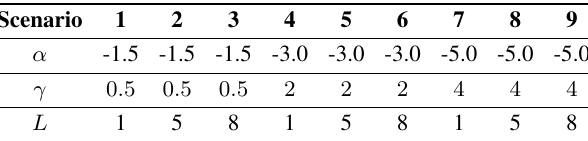
Table 1. The distinct scenarios for synthetic data